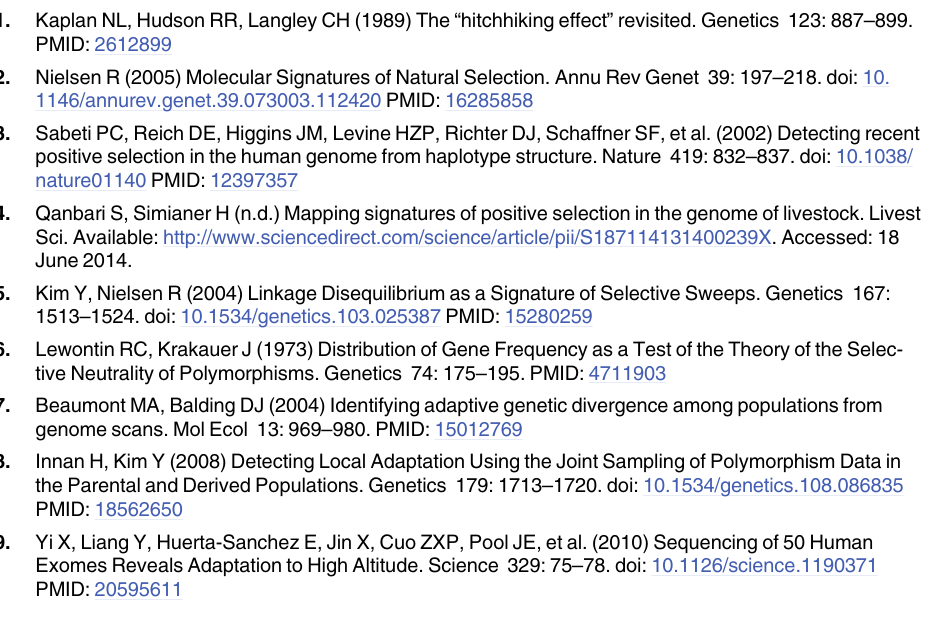
with upper (U) ST